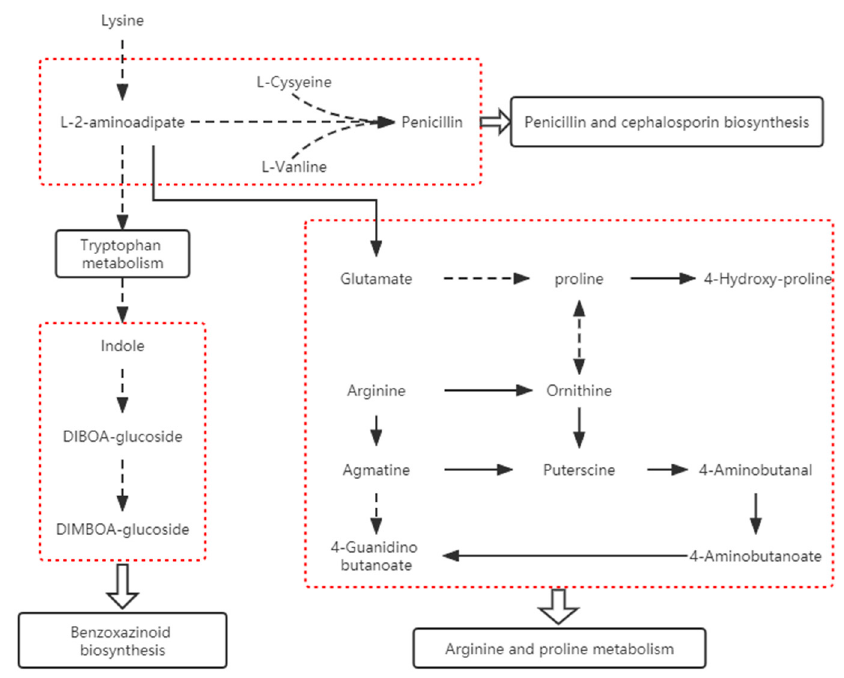
Figure 8. Links between metabolic pathways.